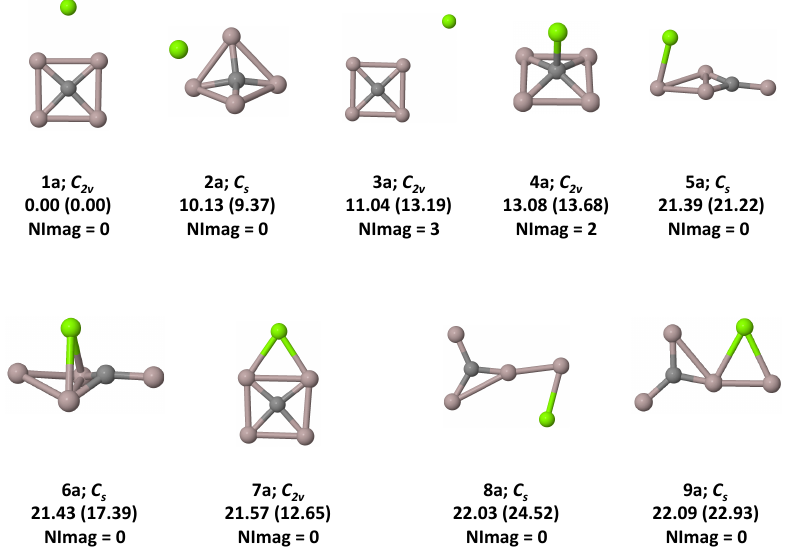
− on the doublet PES. Relative energies including ZPVE Figure 3. Low-lying isomers of CAl 4 Mg correction (in kcal mol − 1 ) are calculated at the U ω B97XD/6-311++G(2d,2p) level. Relative energies obtained at the CBS-QB3 level are shown in parentheses. The number of imaginary frequencies (NImag) obtained for each stationary point are indicated underneath the